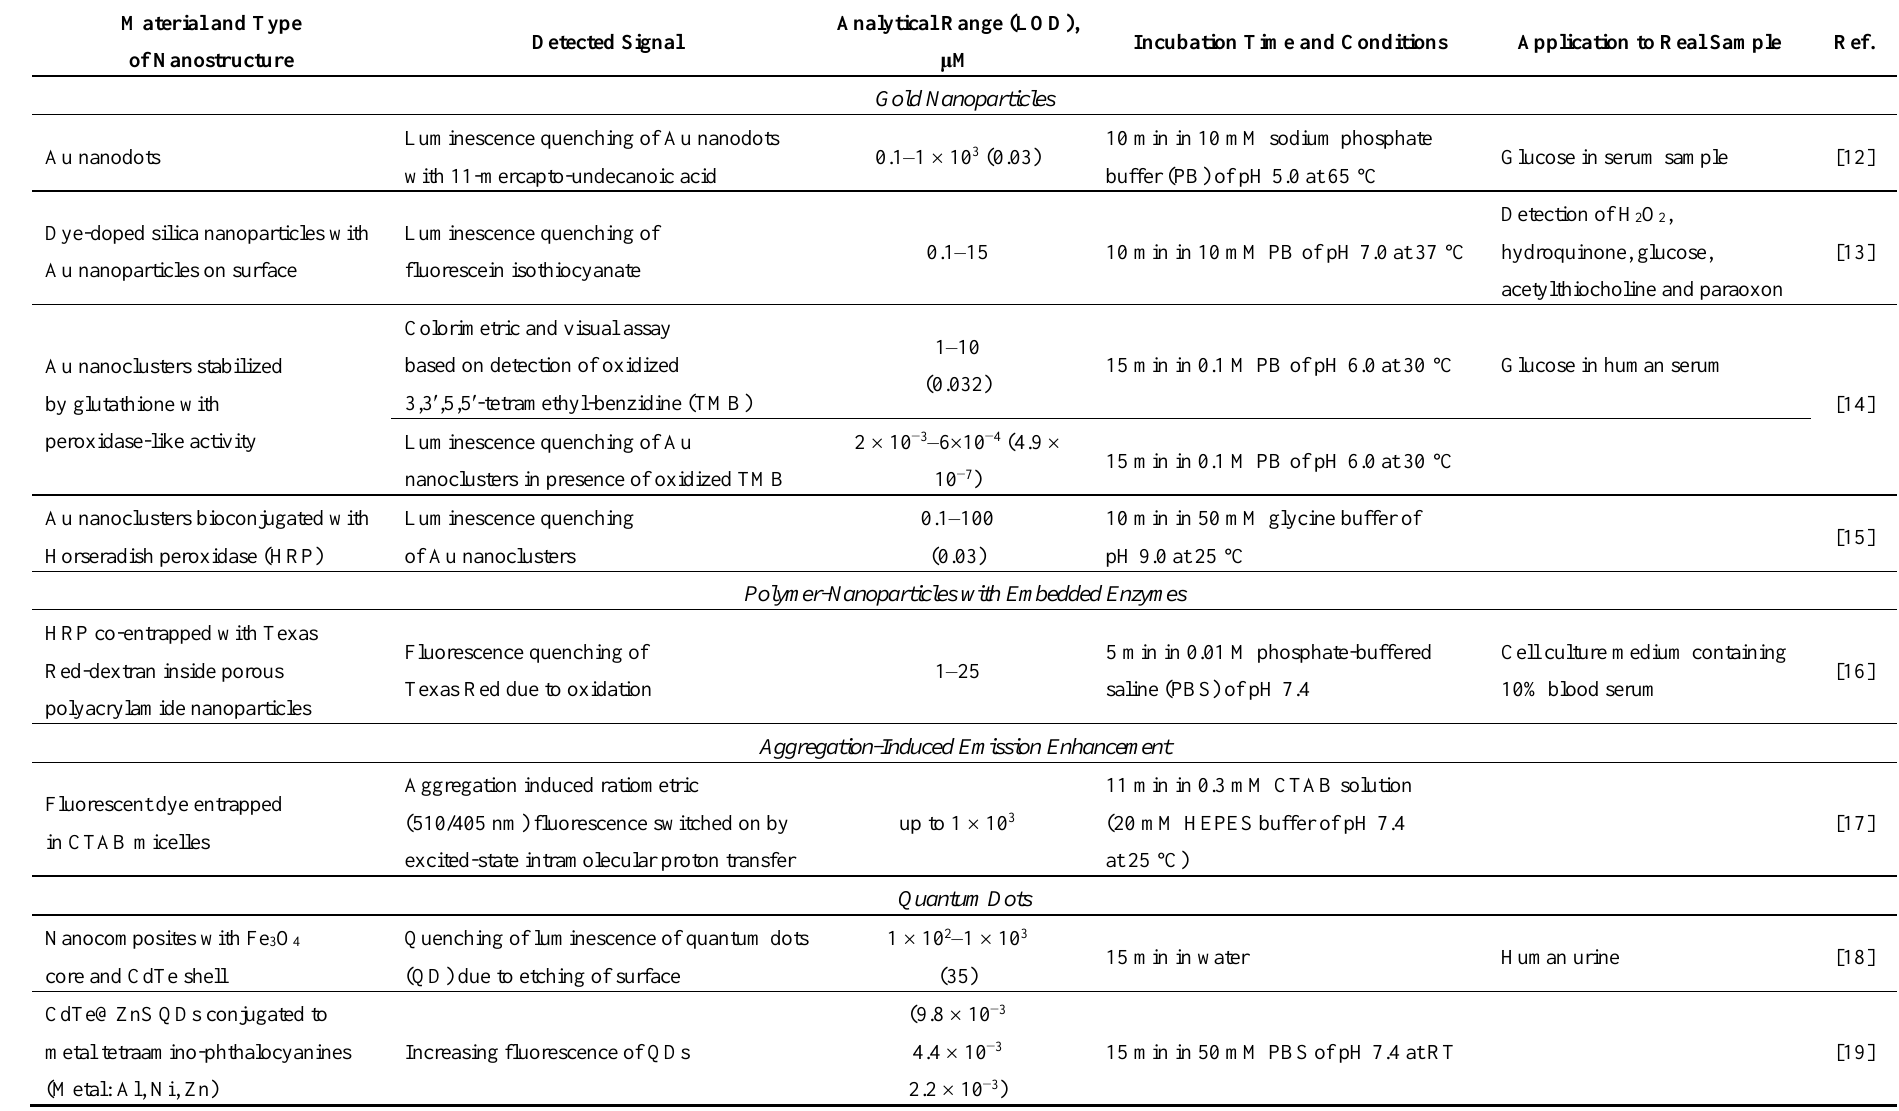
Table 1. Optical Sensors and Probes for Hydrogen Peroxide Based on